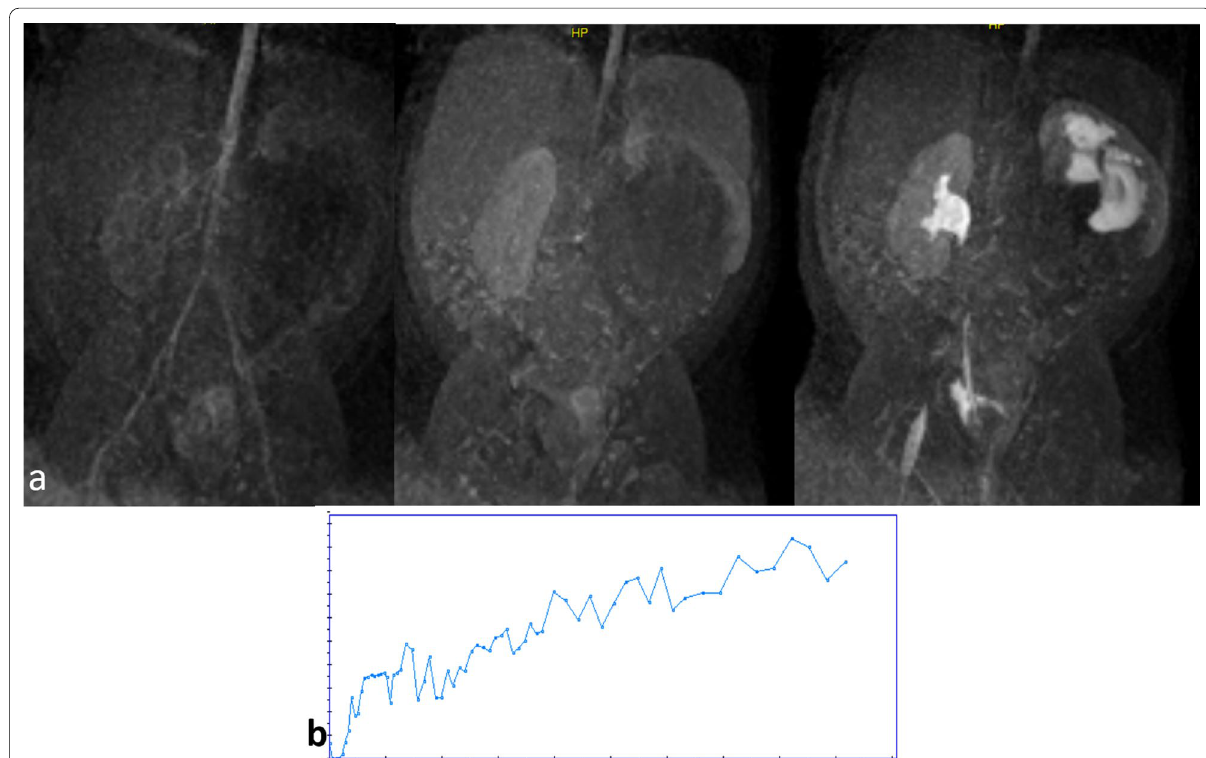
Fig. 7 Dynamic postcontrast MRU of the same case at Fig. 3 left PUJ with left PUJ obstruction. The study reveals delayed cortical enhancement on the left with delayed visualization of the left ureter. Time intensity curves reveal the obstructive pattern on the left side (L) with prolonged RTT more than 15 min